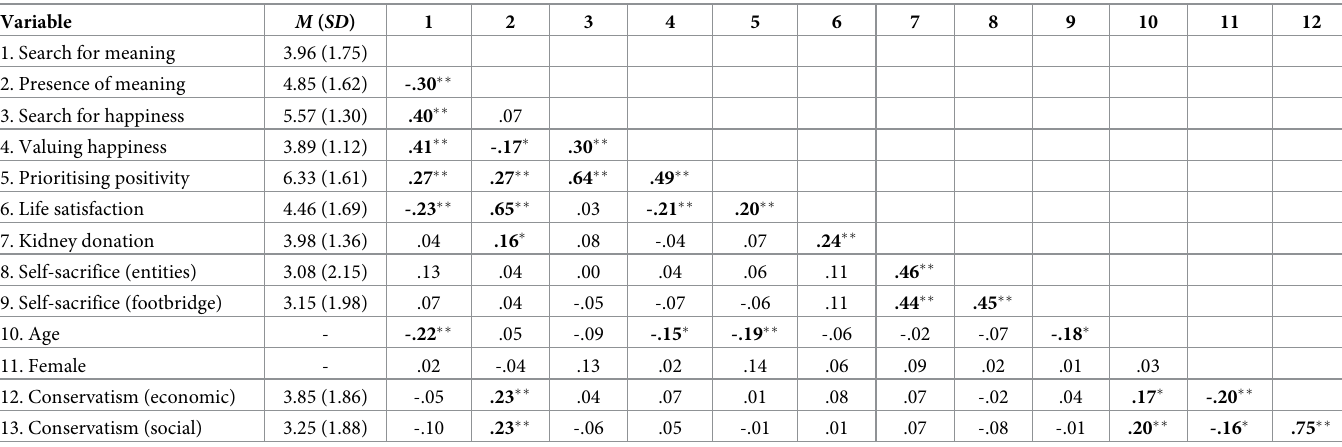
Table 3. Correlations matrix and descriptives in Study 2.